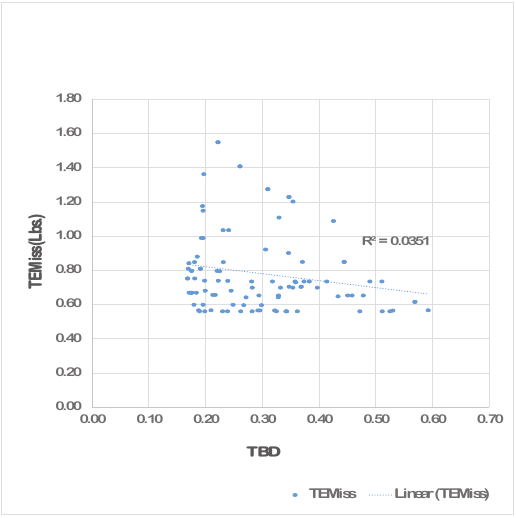
Figure 11. Relation between TBD and TEMiss for a DRSREODLDG-based